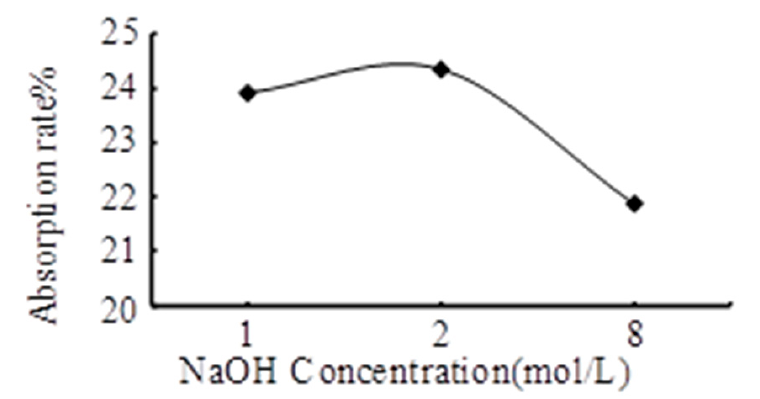
The test was carried out with different concentrations of the NaOH solution, namely 1 mol/L, 2 mol/L, and 8 mol/L. The other conditions remained unchanged and the reaction temperature was controlled at 25 ◦ C. Moreover, the engine operated at the idle speed. The results are shown in Figure 7.